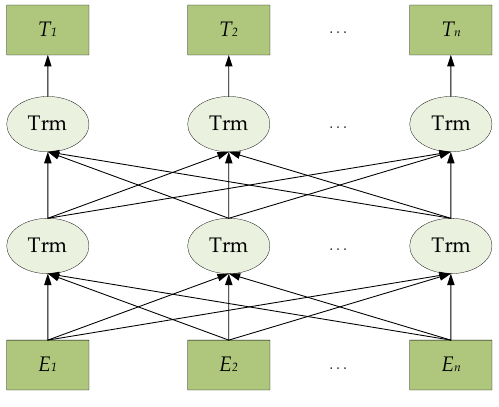
Figure 4. Structure of BERT.